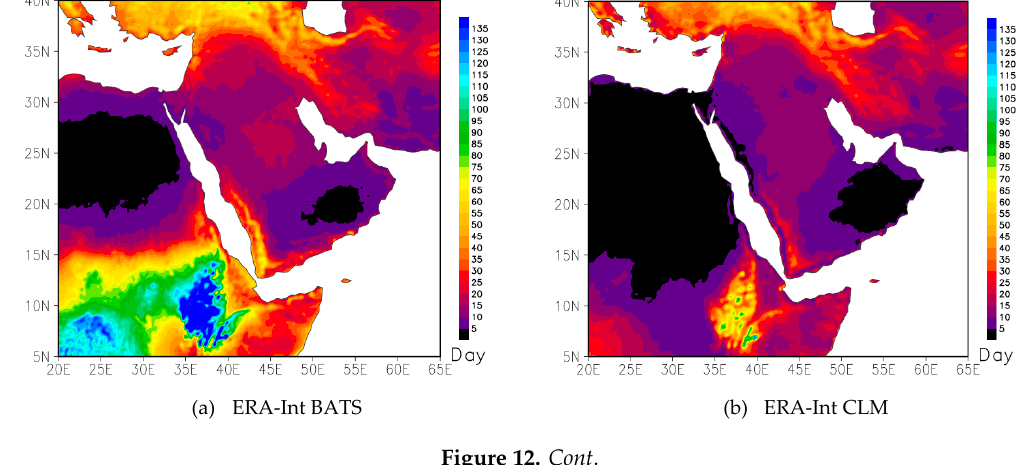
Figure 11. Spatial distribution of the number of annual wet days (R1mm) for ( a ) ERA – Int BATS, ( b ) ERA – Int CLM, ( c ) ECHAM6 BATS, ( d ) ECHAM6 CLM, ( e ) GFDL BATS, ( f ) GFDL CLM, ( g )